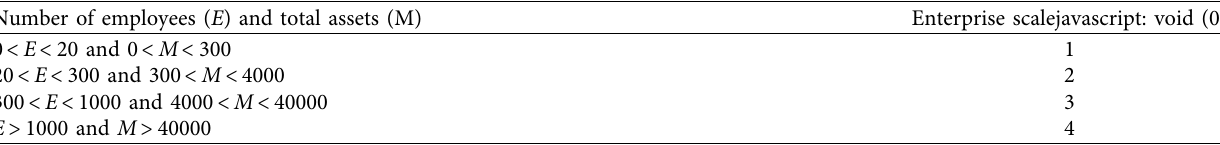
Table 4: Grade transformation of enterprise scale.